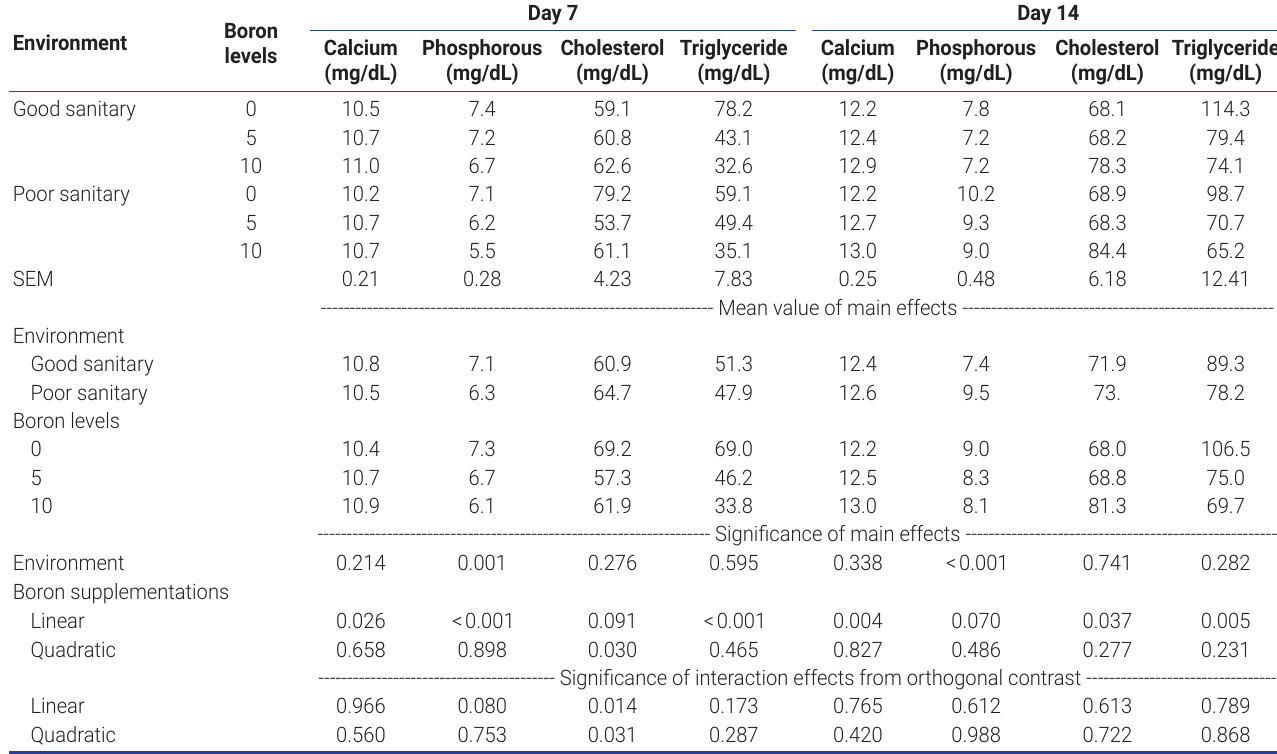
Table 6. Effects of environment and boron levels (mg/kg) on nutrient composition in systemic plasma of weaned pigs on days 7 and 14